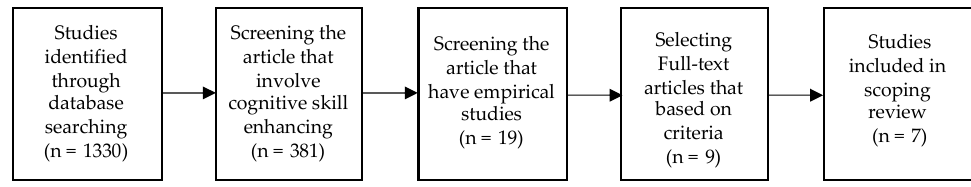
Figure 3. Literature search and selecting flow .